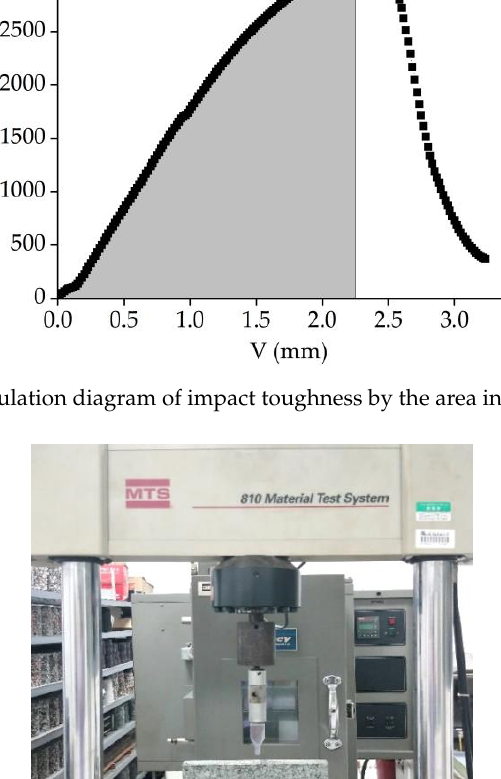
( c ) Figure 2. Three types of stone beam specimens: ( a ) diabase, ( b ) granite, and ( c ) limestone. 3.3. Three-Point Bending Test A three-point bending test was conducted to evaluate the effect of the three aggregate types on the EAC flexural cracking behavior. Under continuous loading of the beam specimen, cracks formed and developed inside the mixture, eventually resulting in specimen fracture. The impact toughness ( A K ) of a material reflects its ability to resist deformation and fracturing under an impact load. Energy is dissipated from the fracturing of a beam specimen under the impact load. The load–displacement curve of the test data was used to calculate the EAC impact toughness by the area integral method using Origin software (Origin 2018, OriginLab, Northampton, MA, USA). The area under the loading portion of the load deflection curves, up to the maximum load, was measured from the curves presented in Figure 3. Zhang [23] conducted three-point and four-point bending tests and determined a good positive correlation between A K and fatigue performance in an EAC. In the present study, EACs with three types of aggregates were formed by the slab roller compacting method. After curing, the EACs were cut into beam specimens with dimensions of 250 mm in length, 30 mm in width, and 35 mm in height. The fracture property differences among the EACs, the base asphalt mixture, and